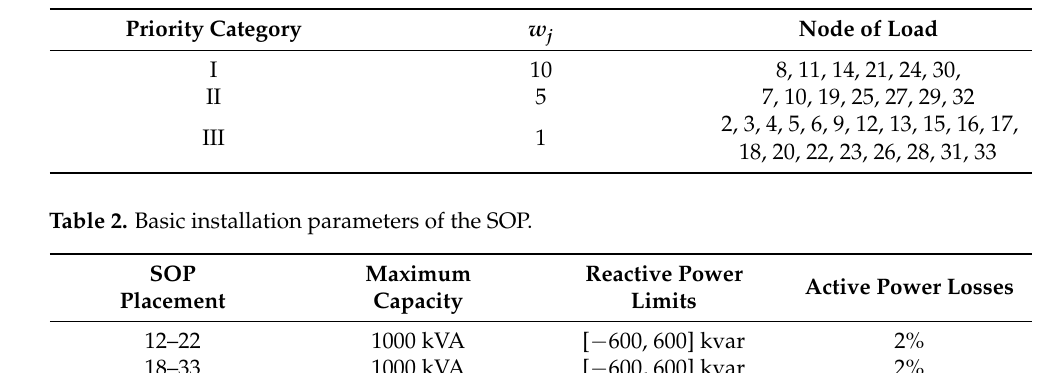
Table 1. Priority weight coefficient of load.